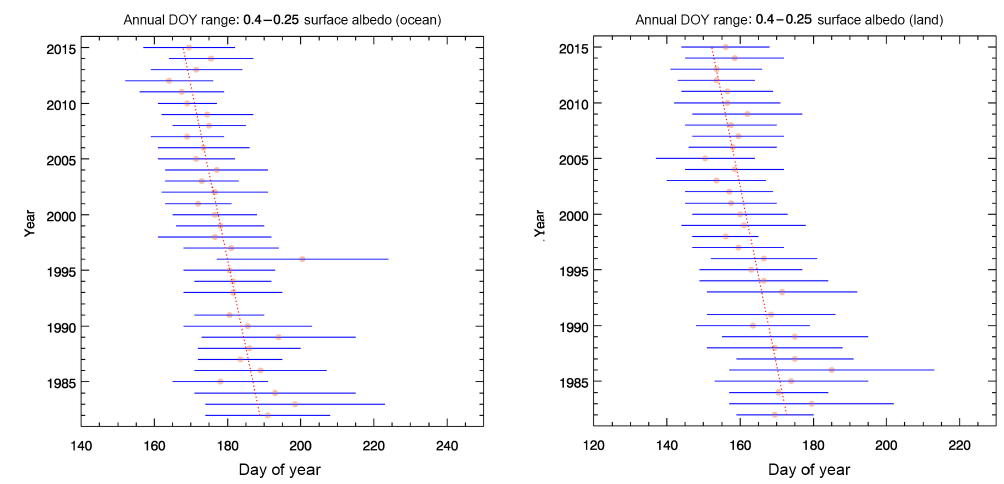
Figure 5. Day-of-year range between 0.4 and 0.25 of albedo over ocean and land (blue) from 1982 to 2015. The dotted trend line (red) shows the regression of the DOY midpoint (pink) over the time